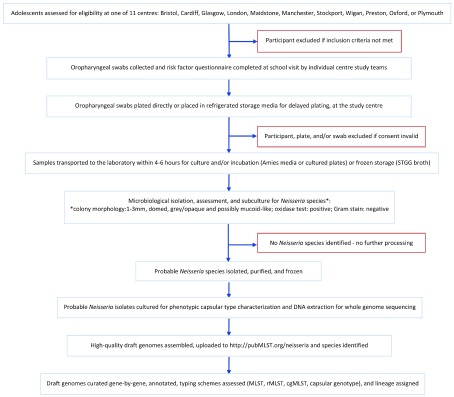
Summary overview of the UKMenCar4 study protocol.A cross-sectional survey of meningococcal carriage, conducted from September 2014 to March 2015.